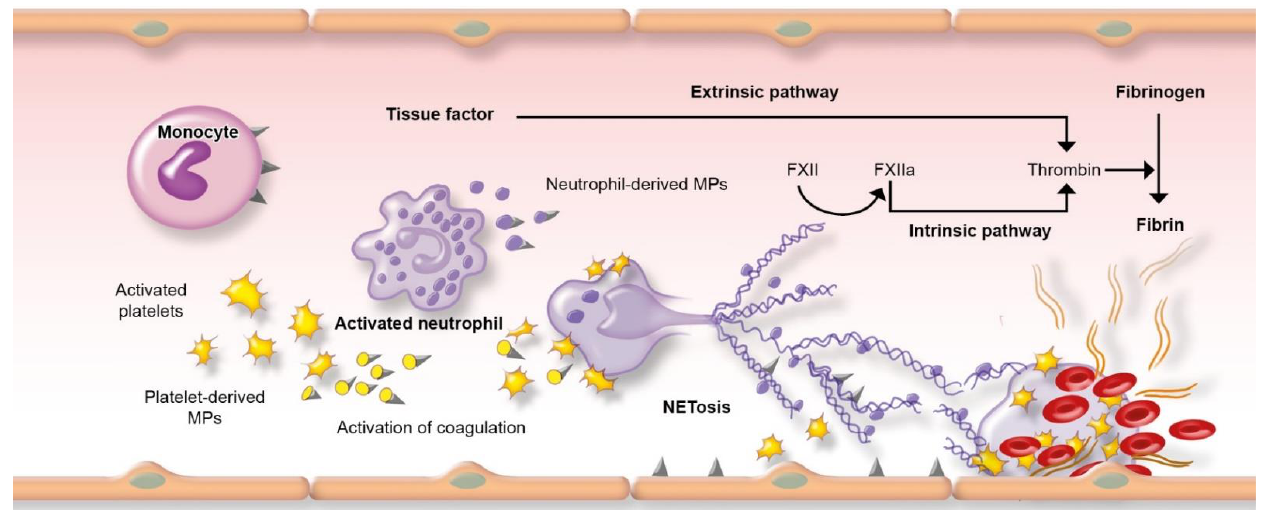
Figure 2. Schematic representation of thrombosis (adapted from Iba et al. [12]). Tissue factor (TF) is the pivotal initiator of the extrinsic pathway of cascade coagulation. In infection/inflammation, TF is expressed on monocytes, endothelial cells, activated platelets, and leucocytes. TF containing microparticles (MPs), mainly neutrophil- and platelet-derived MPs, represent the major source of circulating TF in plasma. NETosis occurs after stimulation of neutrophils by pathogens, activated platelets, and pro-inflammatory cytokines. NETs (neutrophil extracellular traps) are networks mainly constituted of DNA and histones that bind to pathogens and promote both the intrinsic and extrinsic coagulation pathways through the activity of serine proteases (elastase, cathepsin G) presents on NETs: serine proteases inhibit TFPI (tissue factor pathway Inhibitor), promoting TF and FXII-dependent coagulation. NETs also bind directly FXII and, in cooperation with platelets, support its activation to FXIIa leading to direct activation of the intrinsic pathway of coagulation.